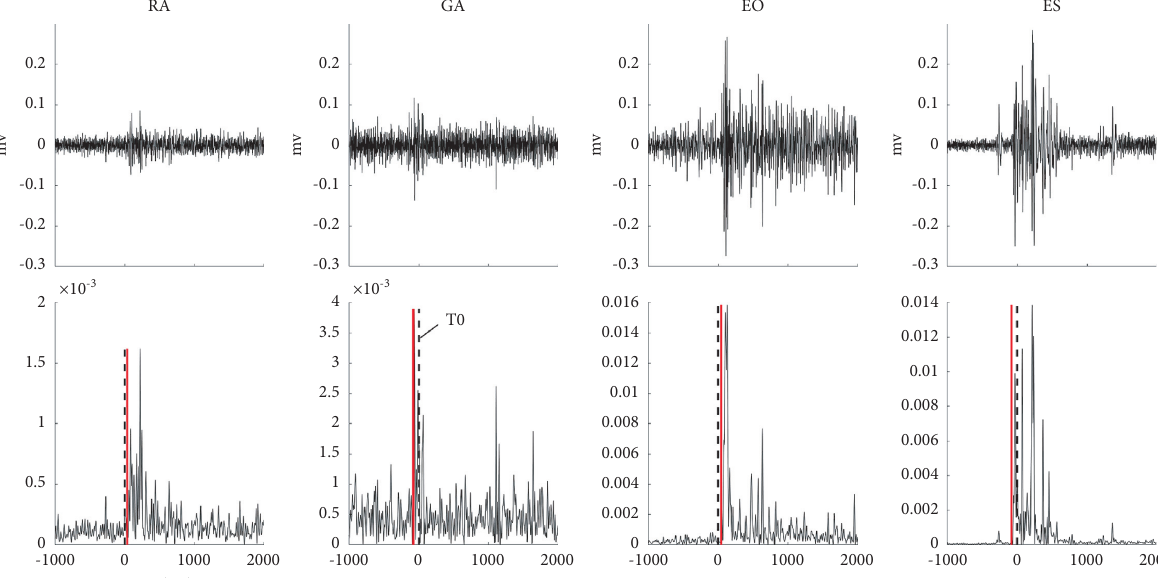
Figure 2: Illustrations of muscle onsets detected by the TKE operation. The upper panel is the raw sEMG data of the four muscles. The lower panel is the sEMG signals after the TKE operation. The black dashed lines are the onset time of the perturbation (T0); the red lines are the muscle onsets for each muscle. RA, rectus abdominis; GA, gastrocnemius; EO, lateral external oblique; ES, erector